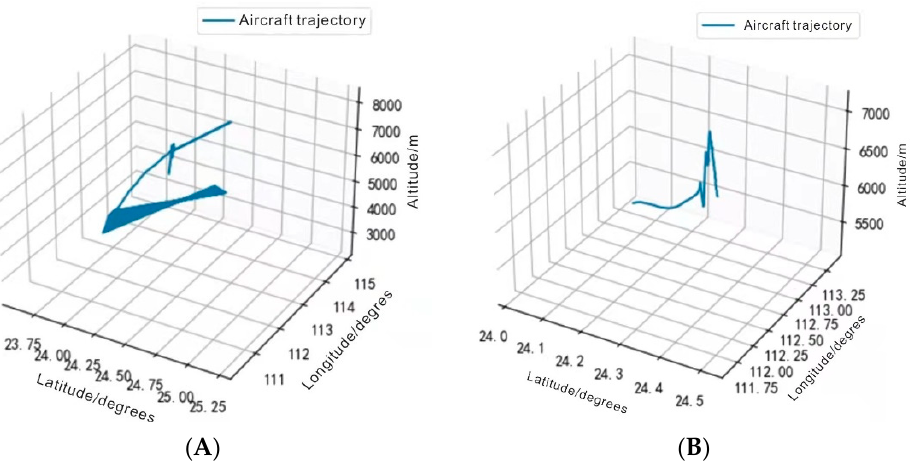
Figure 2. Invalid trajectory. ( A ) Invalid trajectory at higher altitudes. ( B ) Invalid trajectory at lower altitudes.